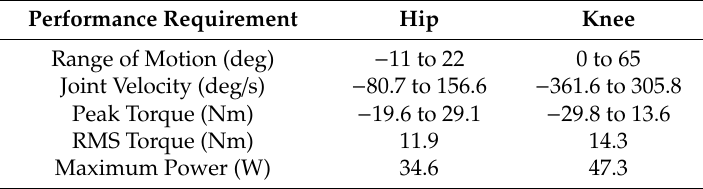
Table 1. Performance requirements for a 1.1 s gait period.